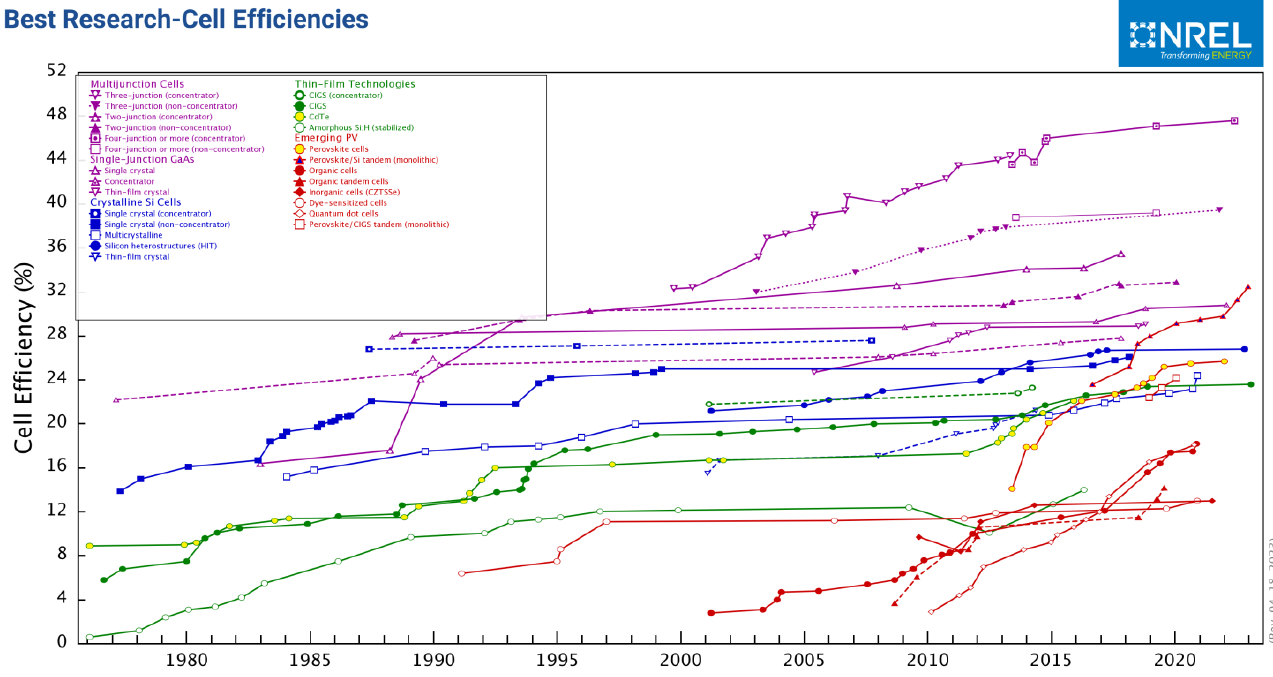
Figure 7. Best Research-Cell Efficiency Chart presented by NREL. The plot is courtesy of the National Renewable Energy Laboratory, Golden, CO [70].